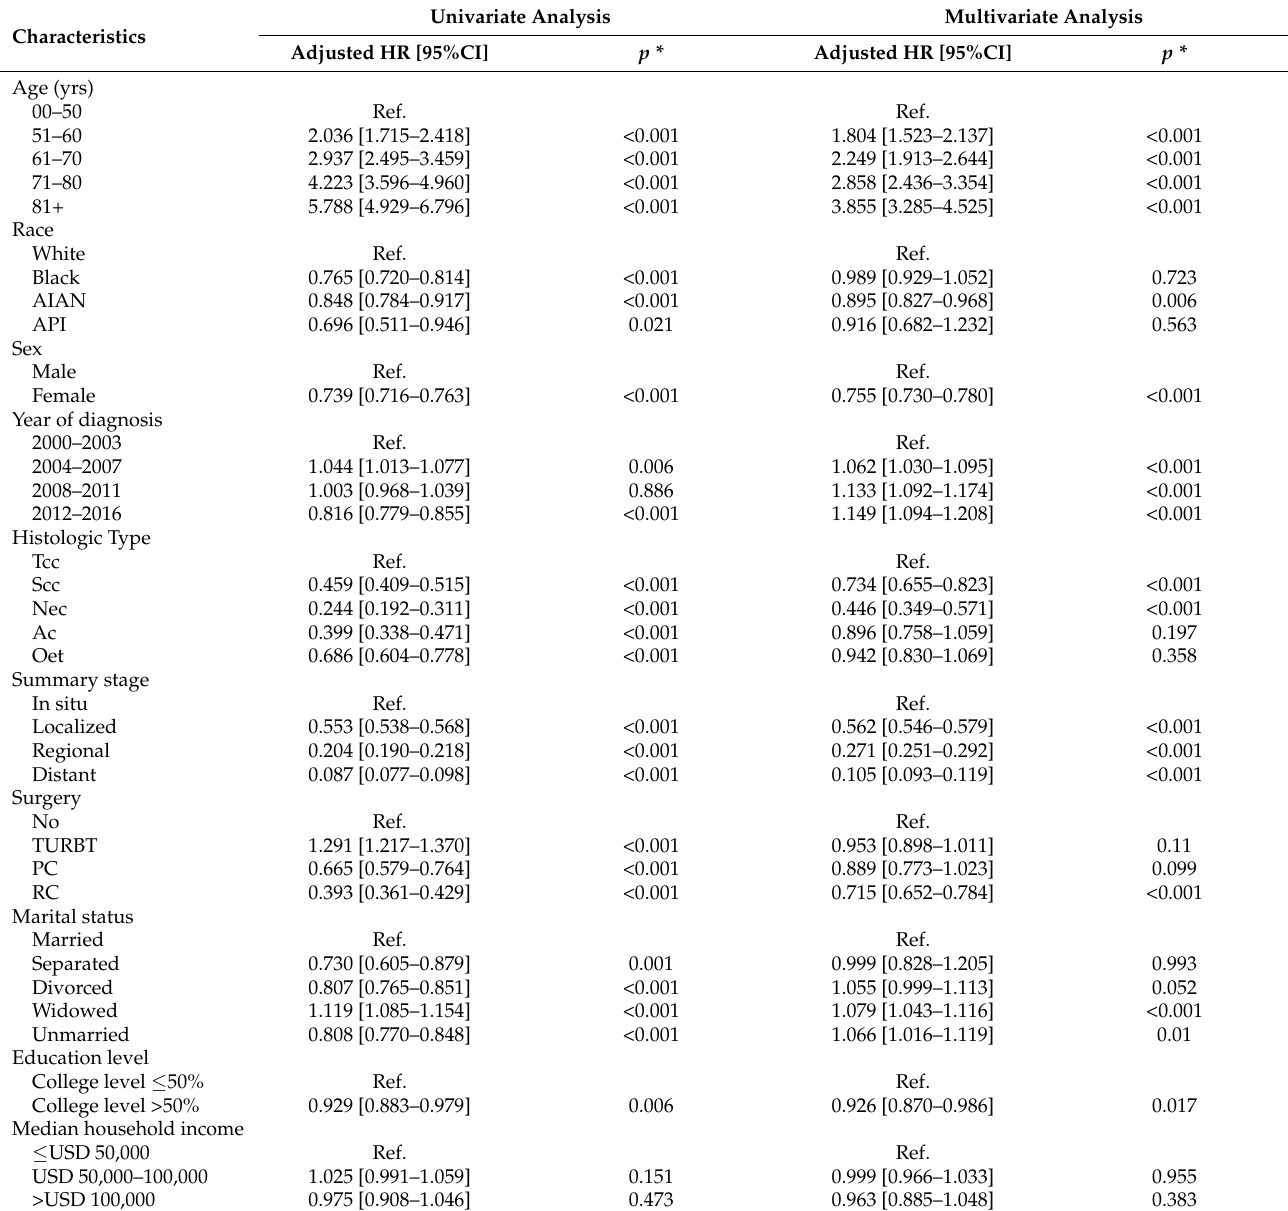
Table 3. Competing risk regression analysis for predictors of cardiovascular mortality in patients with bladder